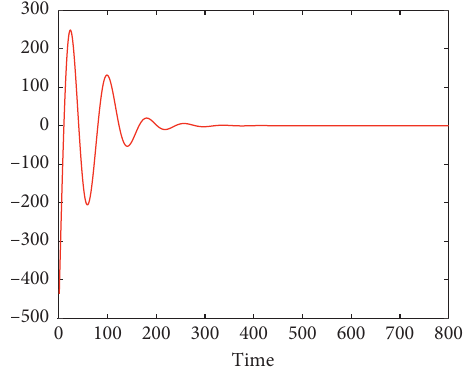
Figure 1: The trajectory of system output y � x